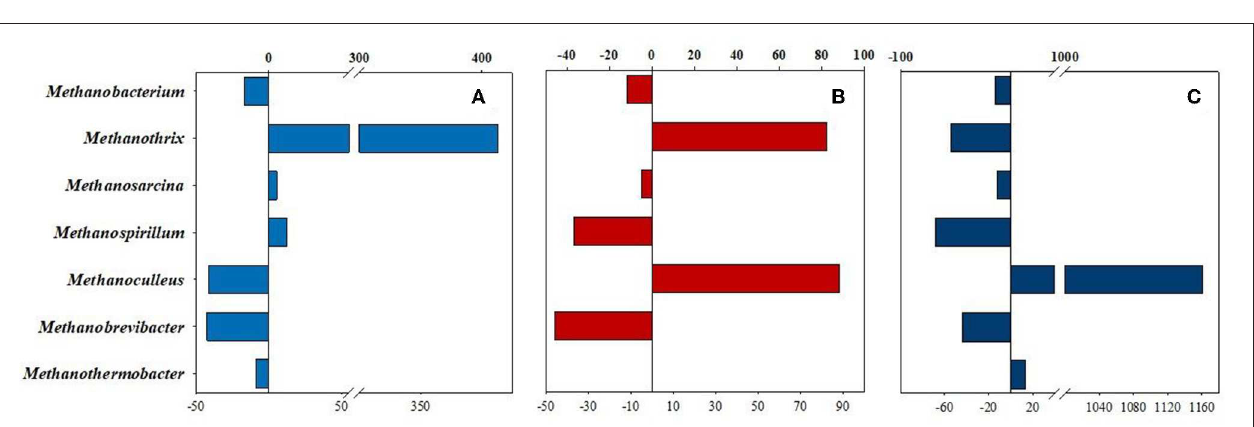
FIGURE 7 | Percentile changes of Archaea relative abundances at genus level. The changes between the reactors supplied with daily H 2 dose and their counterparts, flushed with nitrogen, are compared. (A) Light blue = CH-CN, (B) Red = SH-SN, and (C) Dark blue = CHw12-CNw12,